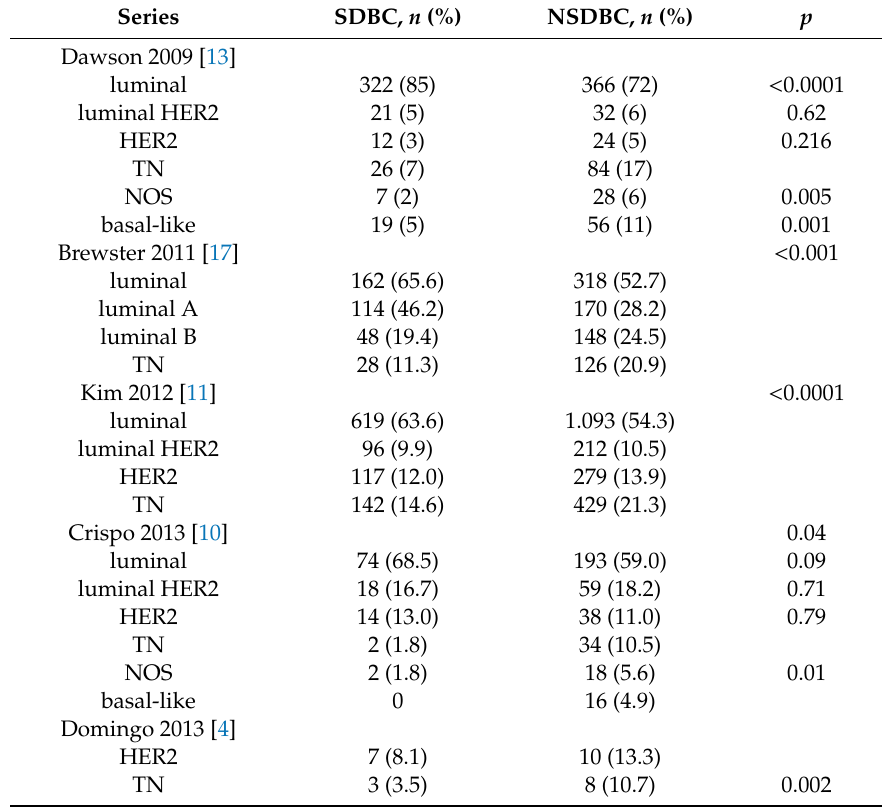
Table 9. Molecular classification